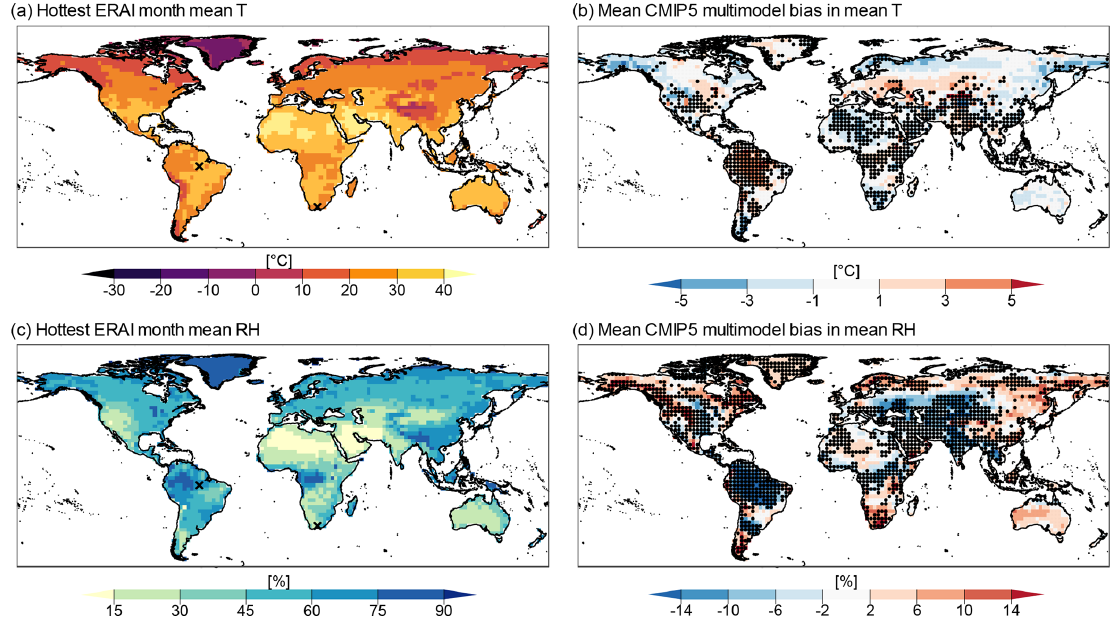
Figure 3. Mean temperature ( T ) of the hottest month in ERA-Interim reanalysis (a) , mean CMIP5 multimodel bias in mean temperature (b) , mean relative humidity (RH) of ERA-Interim reanalysis (c) , and mean CMIP5 multimodel bias in mean RH (d) . Stippling indicates locations where at least 75% of models failed the AD two-sample test between the CMIP5 and ERA-Interim marginal distributions of T and RH. Bias was calculated as (CMIP5 minus